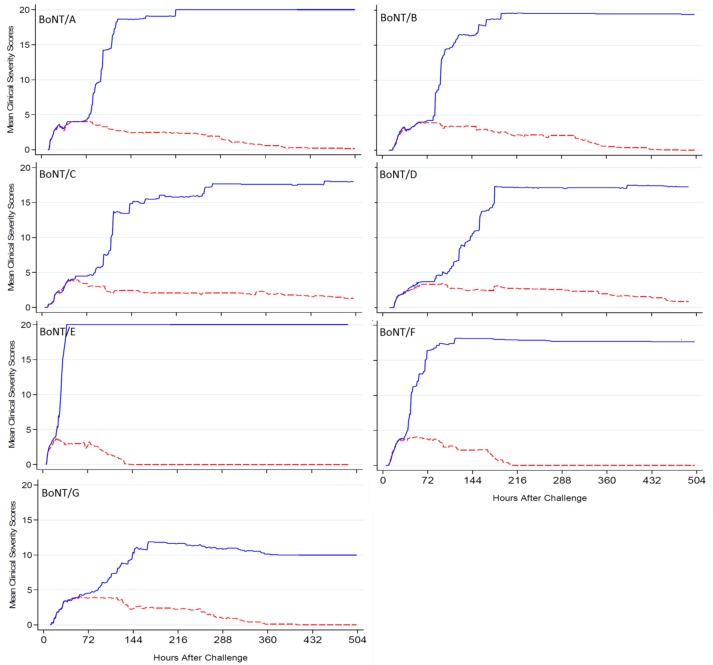
Mean clinical severity scores including scores for dead animals over time (Hours) by BoNT serotype and treatment group.Guinea pigs were intoxicated with 1.5x GPIMLD50 of BoNT serotypes A, B, C, D, E, F or G and subsequently treated with 1.0x BAT product (dashed red line) or placebo (solid blue line). Treatment was initiated after four consecutive observations of moderate or severe signs of botulinum intoxication. Animals were assigned a score of 1 (mild signs of intoxication), 2 (moderate signs of intoxication) or 3 (severe signs of intoxication) at each timepoint. A value of 20 was assigned for the time at which an animal succumbed or was euthanized, and for all subsequent time points to end of the study.